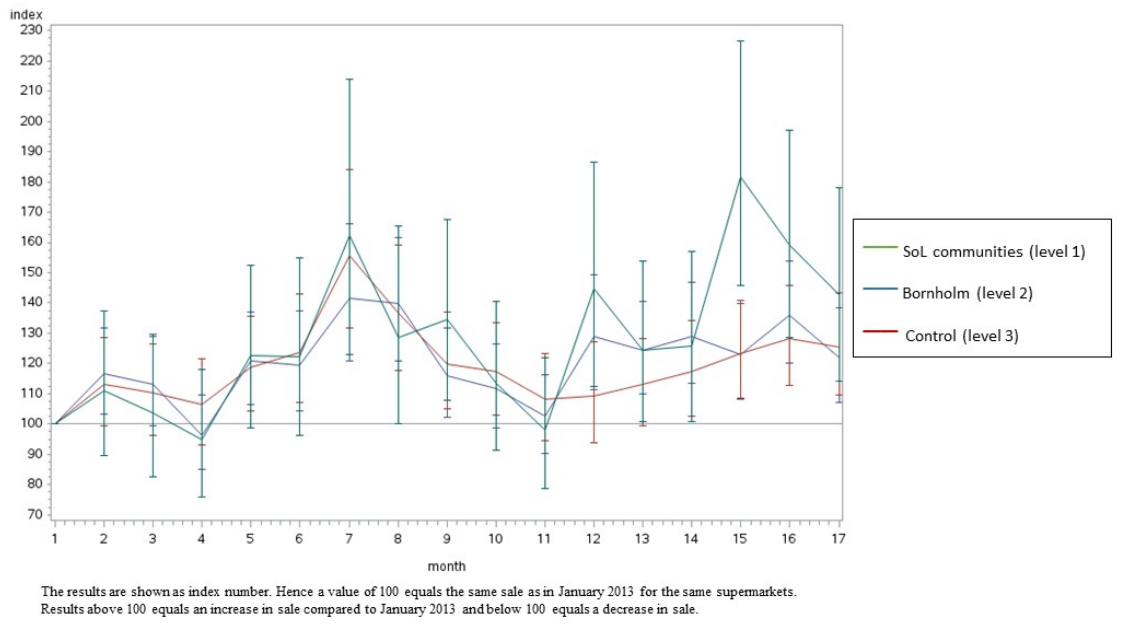
Figure 2. The development in monthly sales of fish (total) from January 2013 to June 2014 in the SoL intervention communities, the Island of Bornholm and the control area (Odsherred). Data are shown as index numbers.